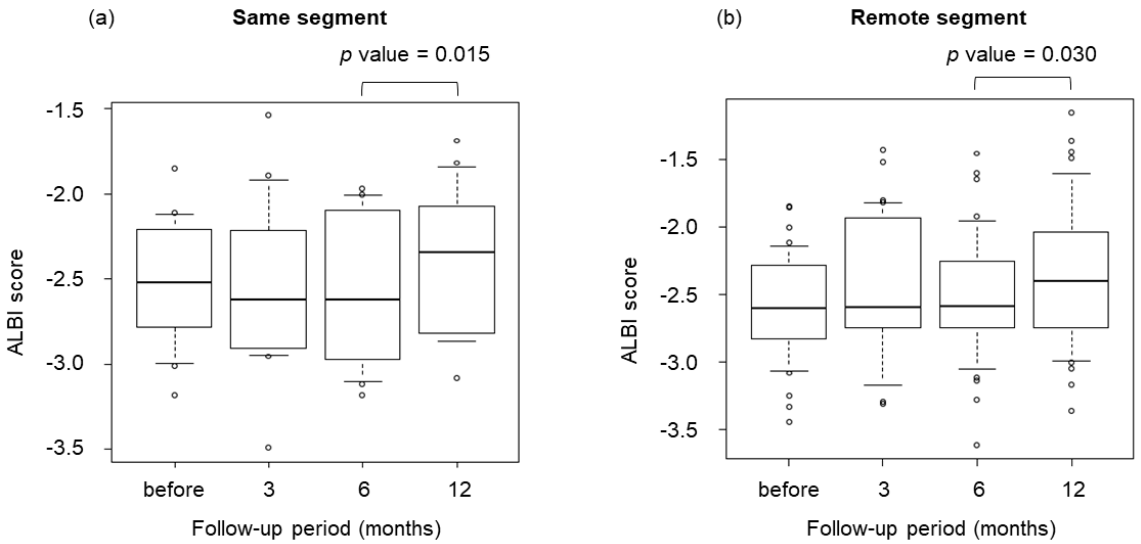
Figure 6. Box-and-whisker plots of albumin–bilirubin (ALBI) scores at 3, 6, and 12 months after SBRT.